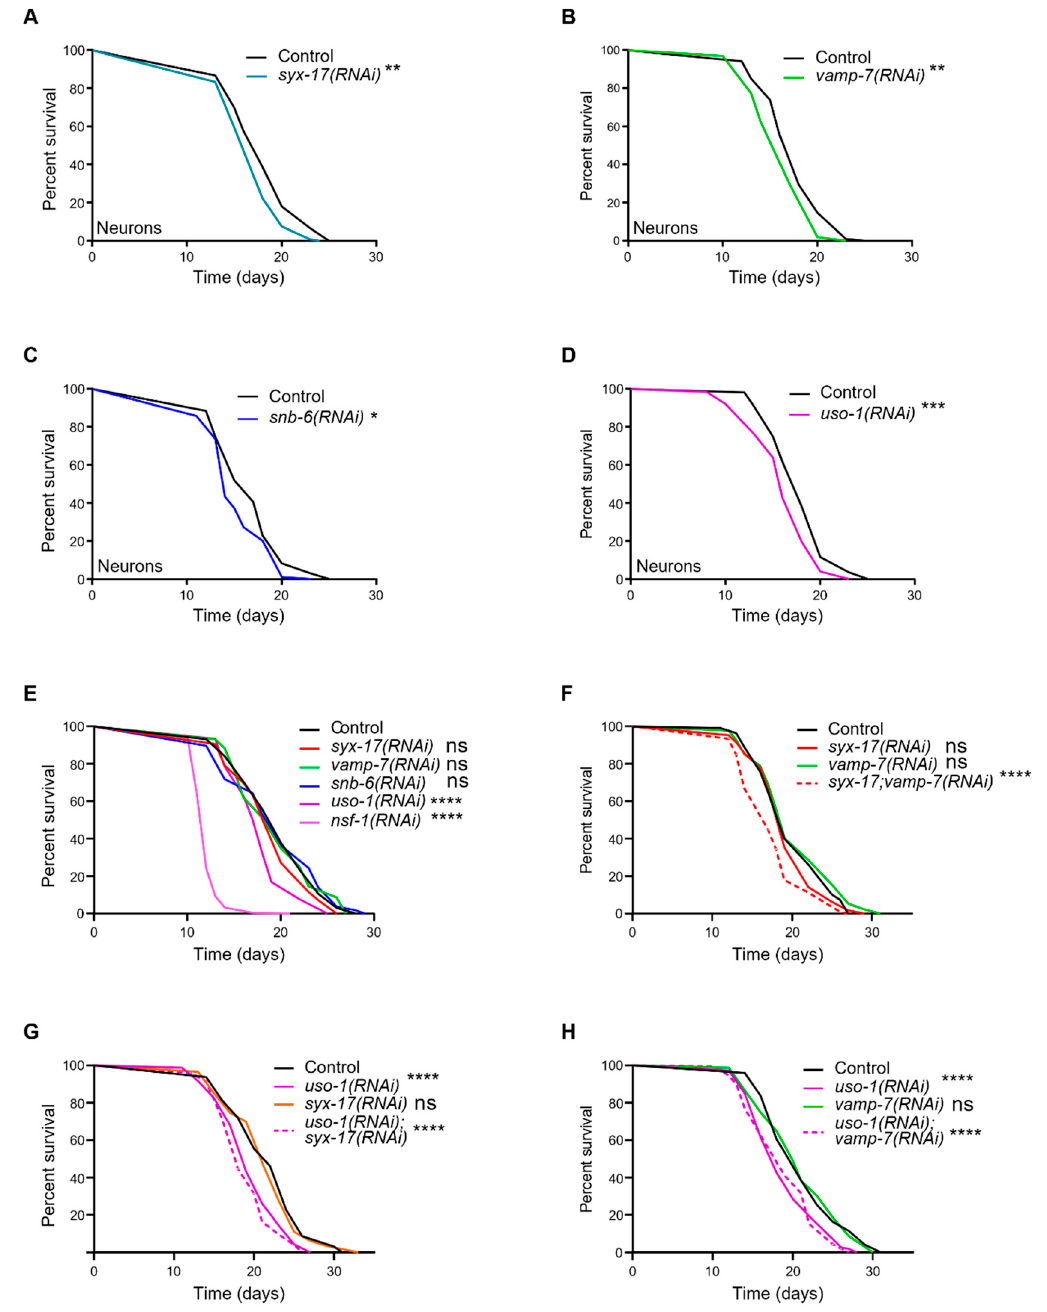
Figure 5. mitoSNARE are essential for normal aging in C. elegans. ( A – D )Neuronal-specific inhibition of mitoSNAREs reduces lifespan of otherwise wild-type animals. ( E ) In non-neuronal tissues, knockdown of syx-17, vamp-7 and snb-6 does not cause any changes in lifespan while nsf-1 and uso-1 RNAi-silencing causes significant lifespan shortening. ( F – H ) Knockdown of syx-17 or vamp-7 does not alter the lifespan shortening observed upon uso-1 RNAi-silencing. Concomitant knockdown of syx-17 and vamp-7 results in a reduction in lifespan while single knockdown does not affect longevity of otherwise wild-type animals. (* p < 0.05, ** p < 0.01, *** p < 0.001, **** p < 0.0001, ns denotes non-significant difference, Mantel-Cox test). Lifespan values are provided in Supplementary Table S1.